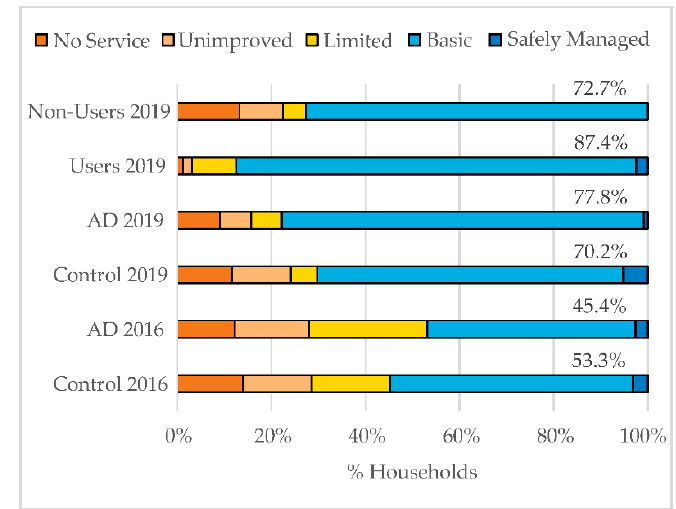
Figure 5. Proportion of households with JMP service levels from 2016 to 2019. Water 2020 , 12 , x FOR PEER REVIEW